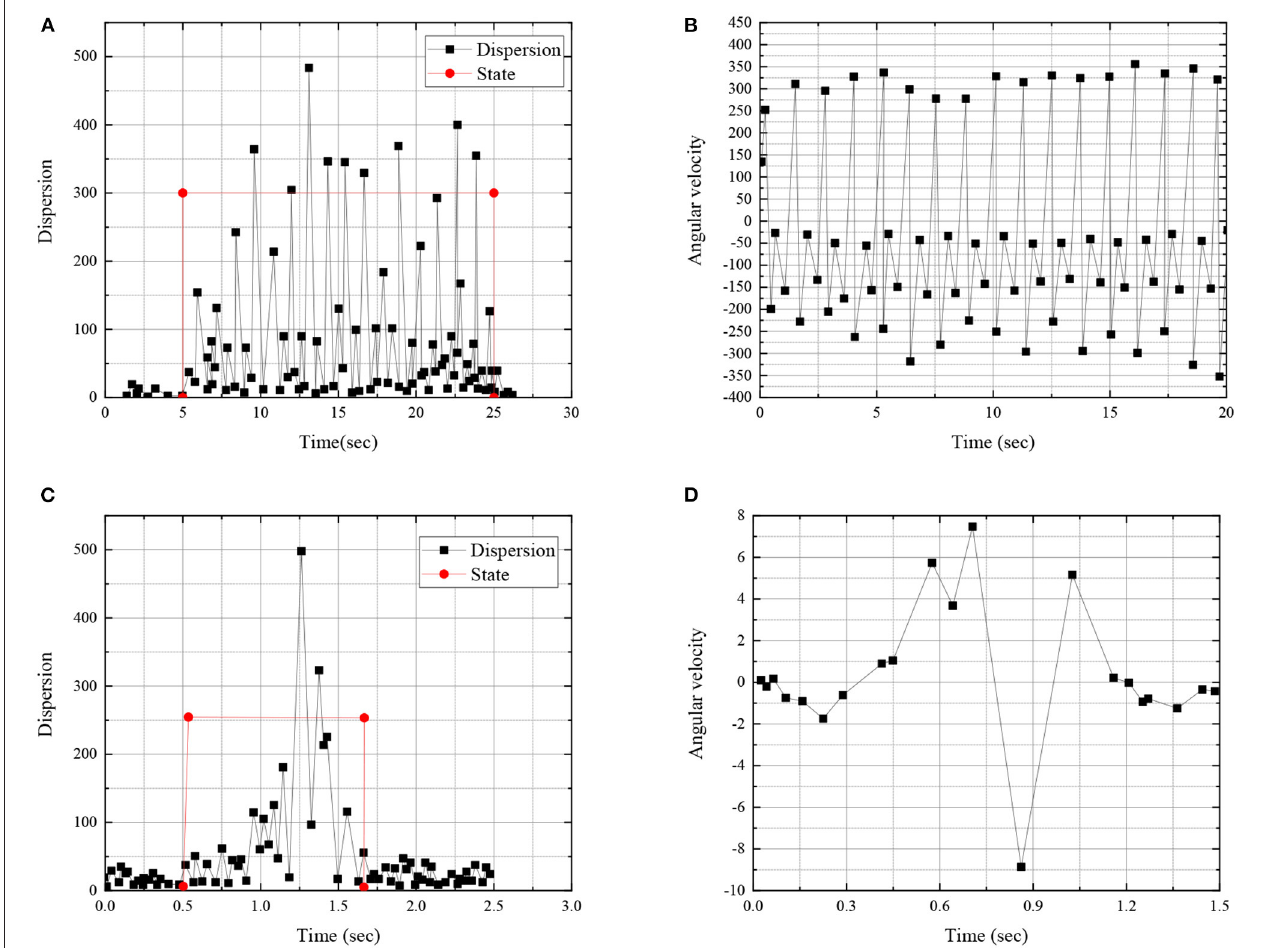
FIGURE 7 | Principle of the data partition method based on discreteness (A) angular velocity discreteness and motion state during walking; (B) angular velocity of legs during walking; (C) angular velocity dispersion and motion state during passing; and (D) arm angular velocity during passing.